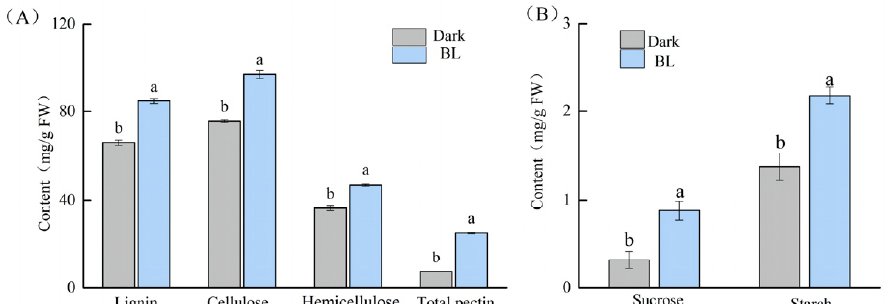
Figure 2. The contents of cell wall composition ( A ) and carbohydrate ( B ) of soybean hypocotyl from plants grown in the dark and under blue light. Values in the table are the mean ± standard error (n = 5). Different letters in the same indicator indicate significant differences between treatments ( p < 0.05).